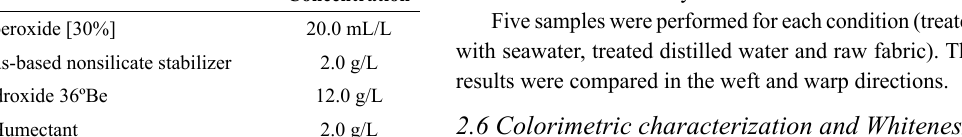
Table 1. Formulation of bleaching process.